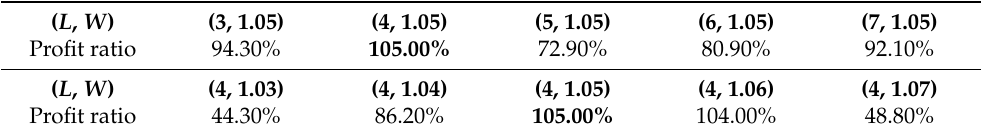
Table 5. Comparison results of different hyperparameters based on the 2016 dataset, where L in ( L , W ) is the length of the signal of IPs and W in ( L , W ) is the threshold of